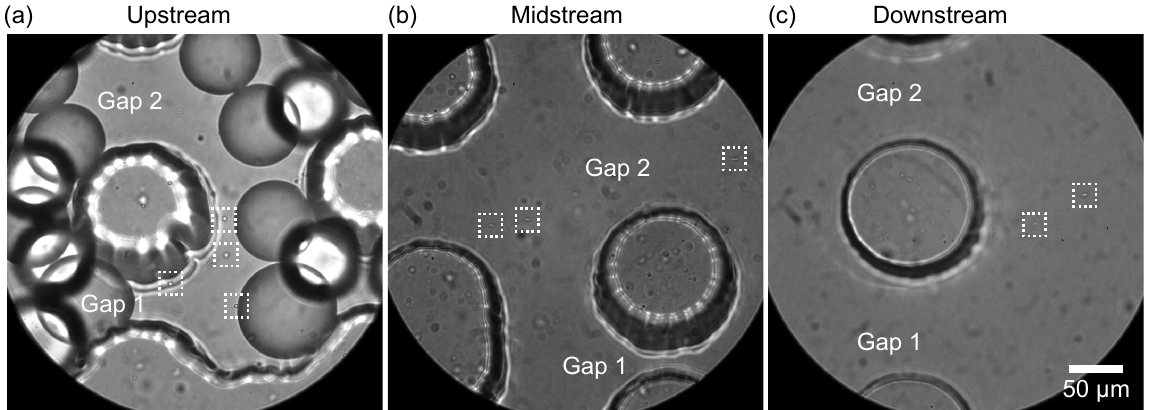
Figure 6. Spatial distribution of main droplets flowing in the no-pillar device. ( a – c ) Main droplets flowing through ( a ) the upstream region immediately after the nozzles, ( b ) midstream region, and ( c ) downstream region before the outlets. Flow rates were Q d = 0.1 mL/h and Q c = 10.0 mL/h.